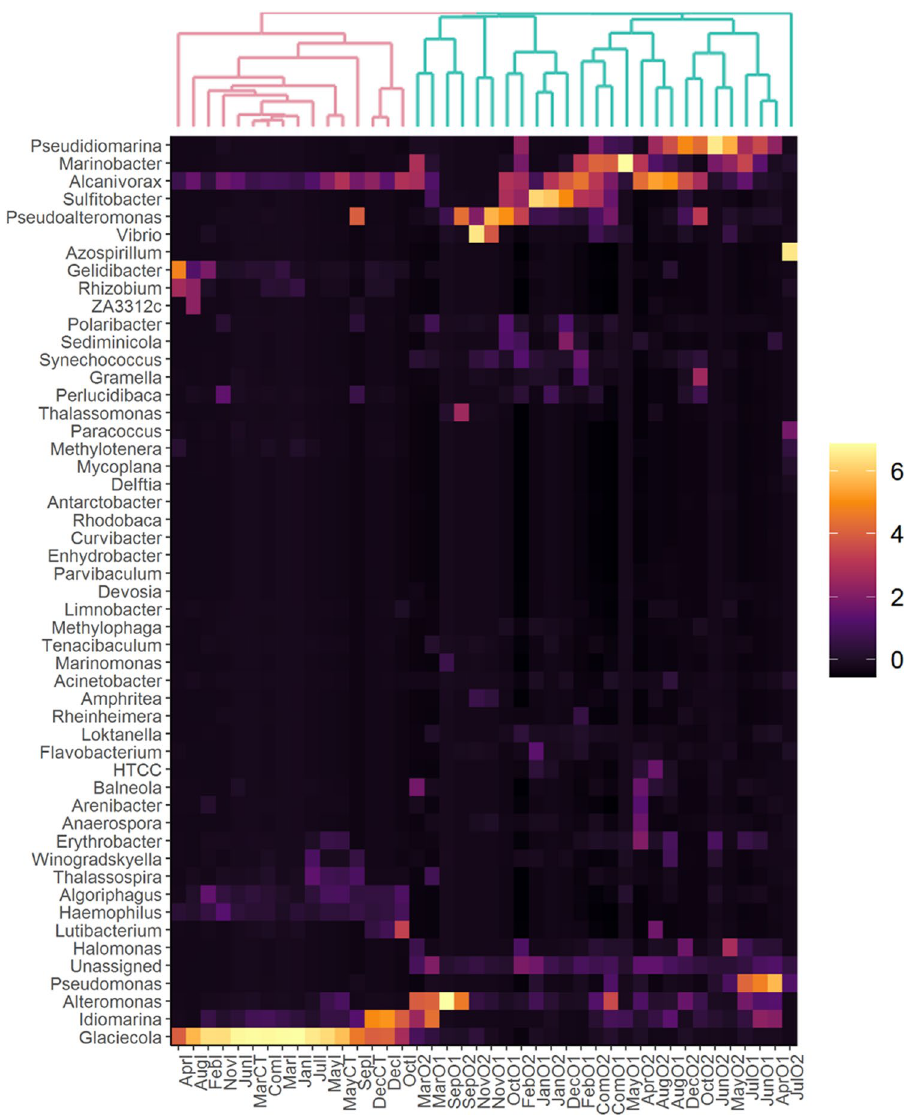
areas. The colour intensity in each panel signifies the relative proportion (%) of respective bacterial genera in a sample. The samples of control groups (shown as pink colour cladogram) clustered separately from those of thermal discharge-impacted groups (shown as green colour